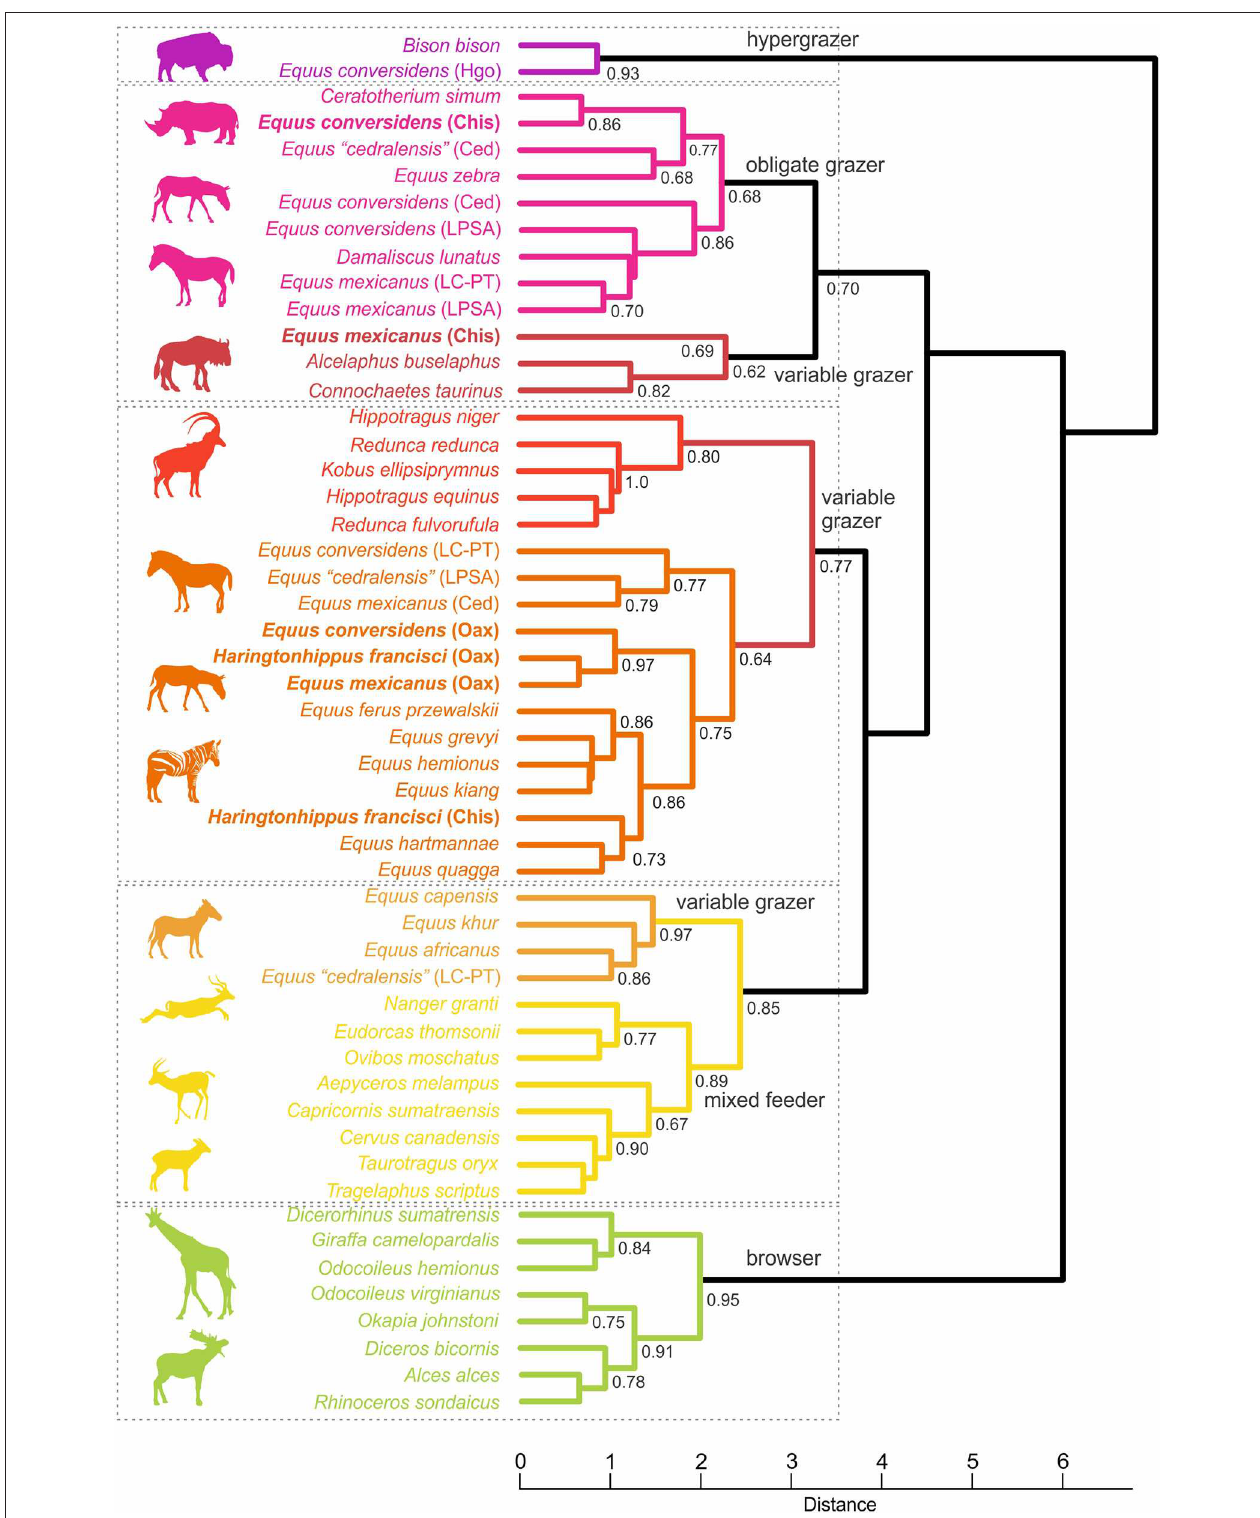
FIGURE 6 | Hierarchical cluster of the mesowear analysis of diverse extant and extinct equid species and other extant herbivorous mammals. The equid species of this study are in bold. Hgo, Hidalgo; Chis, Chiapas; Ced, Cedral locality in San Luis Potosí; LPSA, La Piedad de Santana locality in Michoacán; LC-PT, La Cinta-Portalitos locality in Michoacán; Oax, Oaxaca.